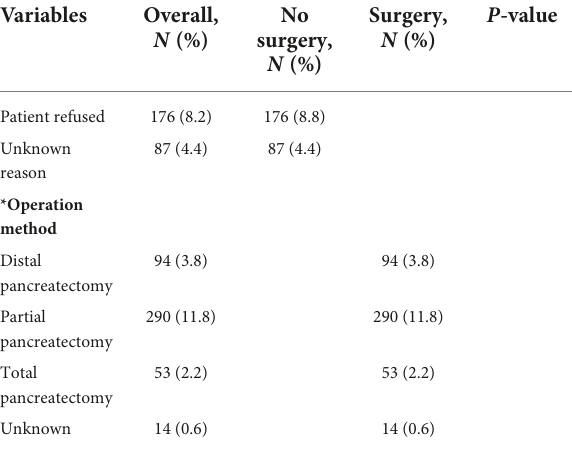
TABLE 1 Clinical characteristics of surgical and non-surgical groups in elderly patients with stage I pancreatic